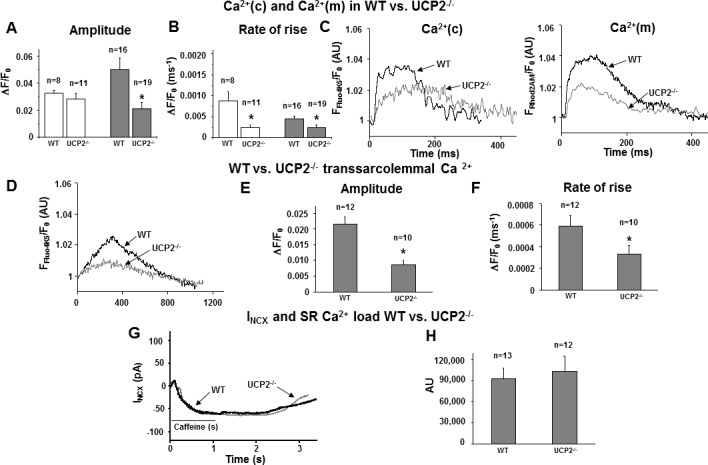
a-c) Ca2+ transients in wild-type (WT) and in UCP2-/- cardiomyocytes (UCP2). a-b) Statistical analysis of (Ca2+)c (left) and (Ca2+)m (right) and c) representative traces of (Ca2+)c (left) and (Ca2+)m (right): In UCP2-/- cardiomyocytes rate of rise of (Ca2+)c was significantly decreased while the amplitude of (Ca2+)c was unchanged vs. WT (*p<0.05). The amplitude and rate of rise of (Ca2+)m of UCP2-/- cardiomyocytes were significantly decreased vs. WT (*p<0.05). d-f) Transsarcolemmal Ca2+ transients in WT vs. UCP2-/- cardiomyocytes evoked in the presence of 0.2 μM ryanodine, 0.01 mM thapsigargin and 100 nM Ru360. d) Representative traces of transsarcolemmal (Ca2+)c in WT and UCP2-/-, and e-f) Statistical analysis of amplitude (e) and rate of rise (f): In UCP2-/- transsarcolemmal Ca2+ transient amplitude and rate of rise were significantly down-regulated (*p<0.05 vs. WT). g) INCX WT vs. UCP2-/- cardiomyocytes: forward INCX was elicited by 1 s of exposure to 5 mM caffeine using a holding potential of -40 mV. No difference in caffeine induced INCX in WT compared to UCP2-/- was found. h) SR Ca2+ load in WT vs. UCP2-/- calculated via the integral of INCX recordings. No difference in SR Ca2+ load between WT and UCP2-/- was detected.